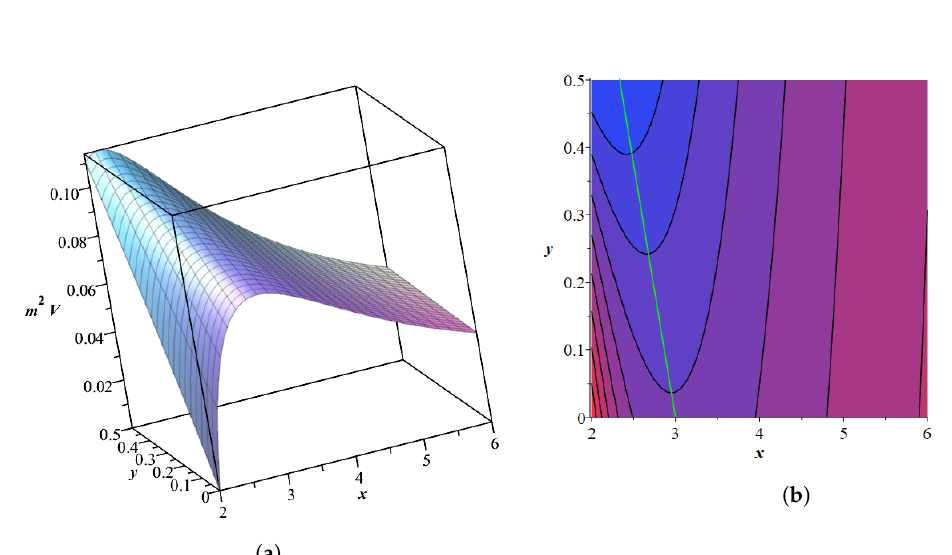
Figure 1. The qualitative features of the spin one Regge–Wheeler potential for the dominant multipole number (cid:96) = 1 are depicted. ( a ) Three-dimensional plot of m 2 V 1 . ( b ) Contour plot. ‘blue’ → ‘red’ corresponds to ‘high’ →